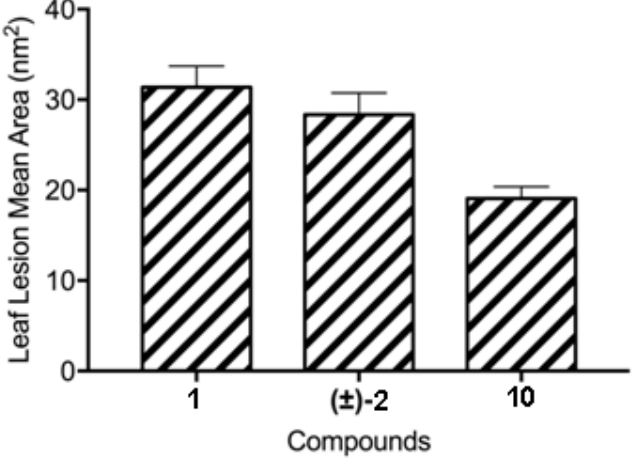
Figure 2. Results of leaf puncture bioassay on buffelgrass ( C. ciliaris ) at concentration of 2.5 × 10 − 3 M for the synthetic derivatives (±)- 2 and 10 and the natural compound 1 .